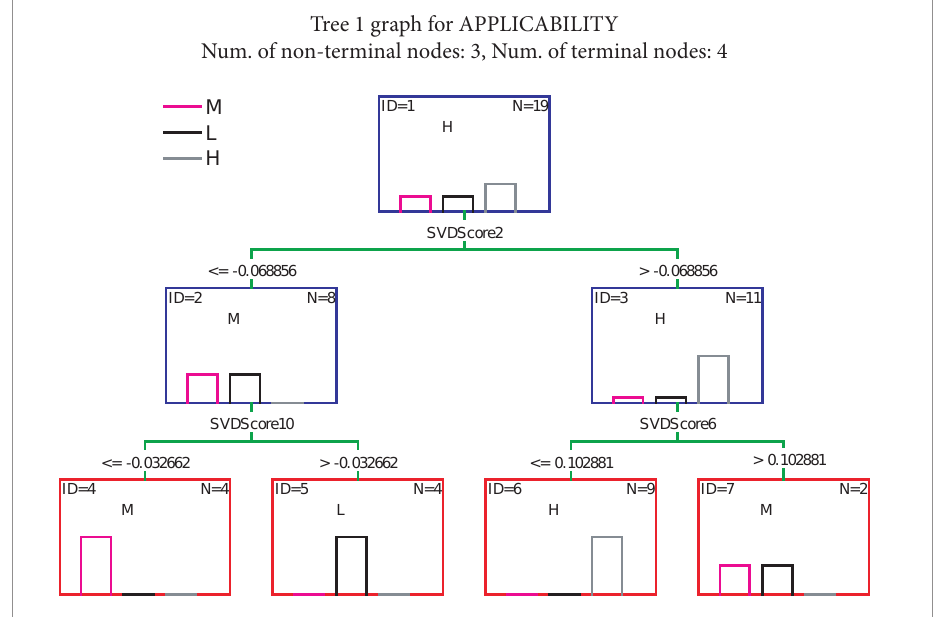
Tree 1 graph for APPLICABILITY Num. of non-terminal nodes: 3, Num. of terminal nodes: